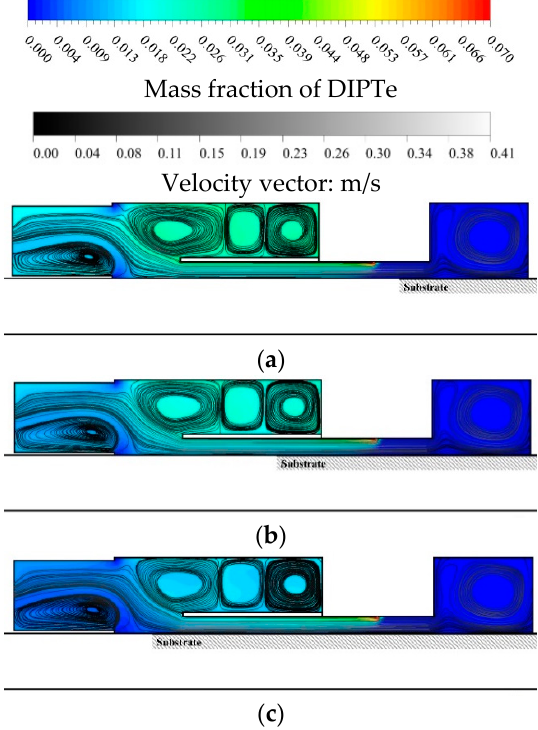
Figure 13. Velocity streamline coupled with mass fraction contour of DIPTe for CdTe growth at a time of 180 s with susceptor moving speeds of: ( a ) 0.75 cm/min; ( b ) 1.50 cm/min; ( c ) 2.25 cm/min.